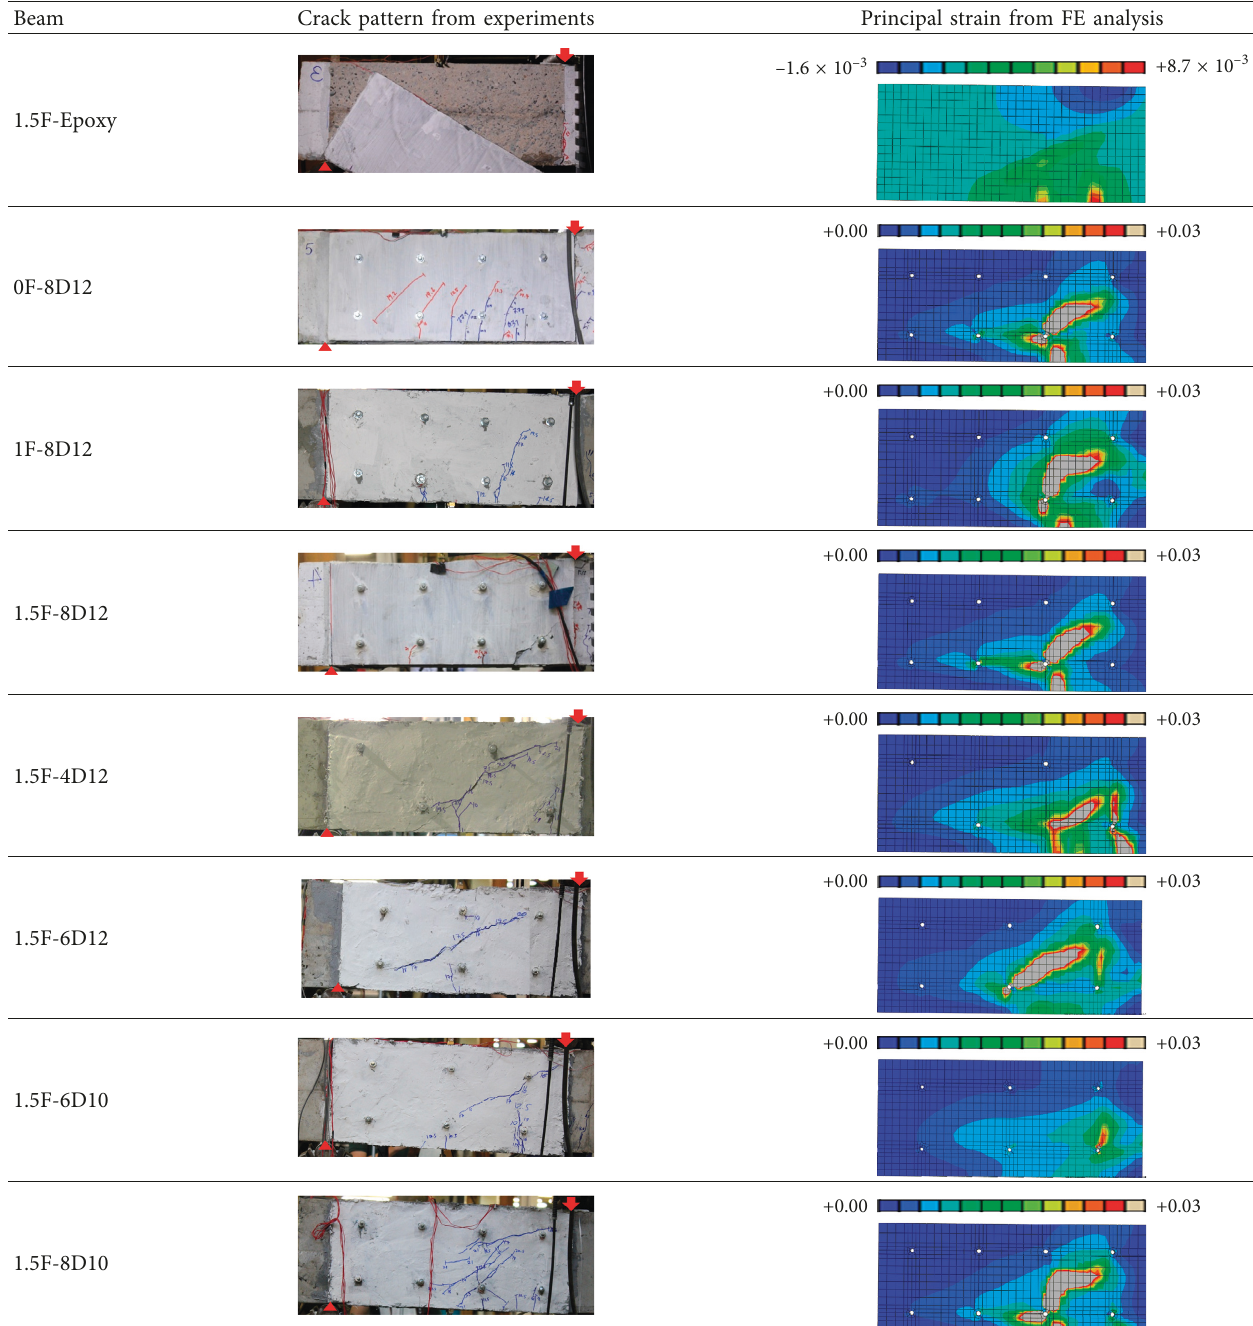
Table 4: Crack pattern of the panels at ultimate load obtained from tests and FE